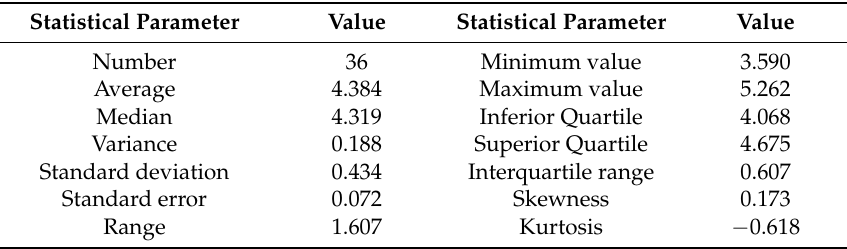
Table 8. UCS analysis of the resulting parts.